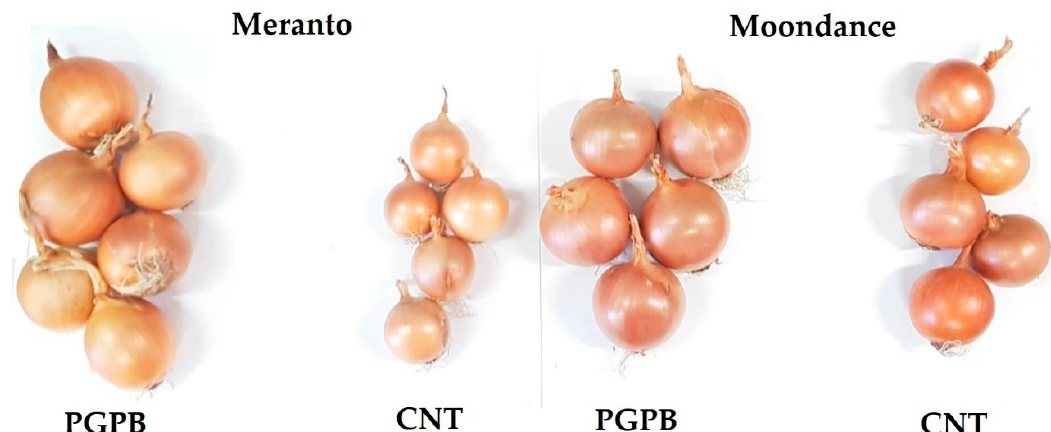
Figure 5. Bulbs harvested from the Control (CNT) and treated (PGPB) experimental units of Meranto and Moondance crops. Table 2. Soil chemical analysis for Meranto and Moondance experimental conditions.